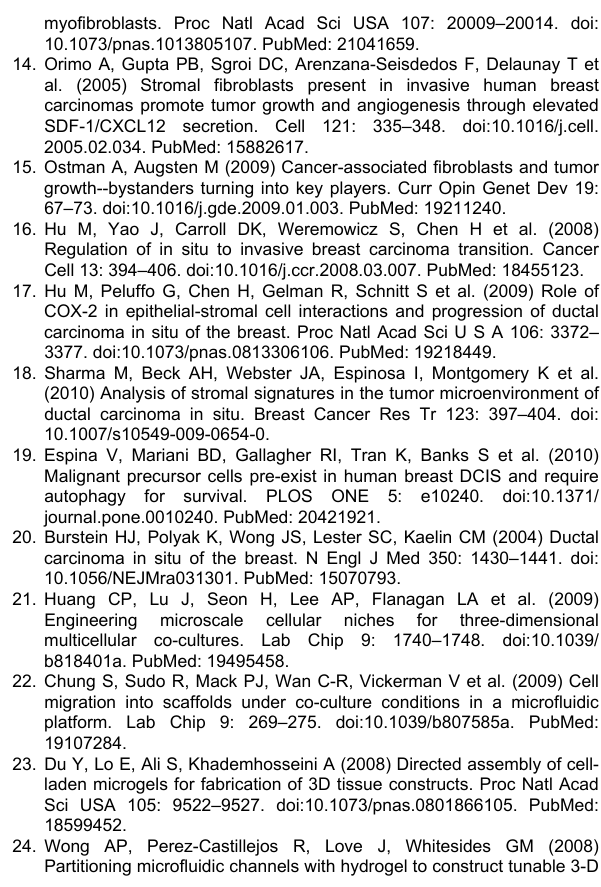
Figure S4. Demonstration of channel loading using red and blue food coloring dyes. Figure S5. Numerical simulation of the diffusion profile in the microdevice containing 3D gel in the center chamber as well as in the outer channels. (A) A set concentration of fluorophore was placed in the outer channels and allowed to diffuse inward. (B) A set concentration of fluorophore was placed in the inner chamber and allowed to diffuse outward.